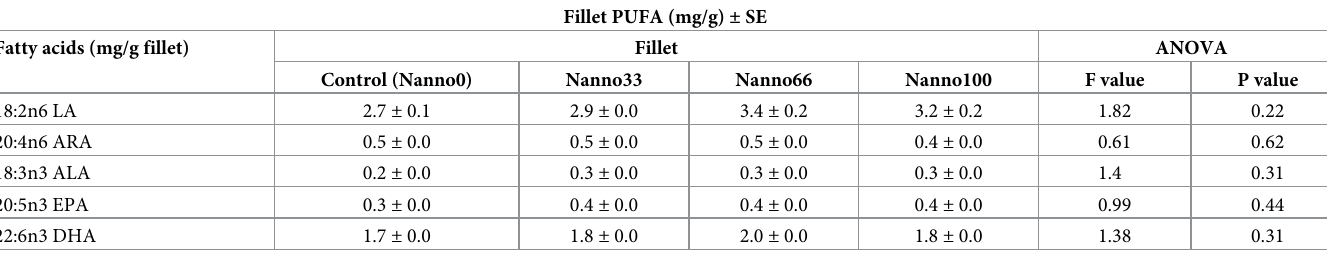
Table 14. Amounts of lipid and major n3 and n6 PUFA in the fillet (wet weight basis) of Nile tilapia fed experimental diets for 84 days; average ± SE for 3 replicates per diet (pooled whole tissues of 5 fish/replicate). Fillet PUFA (mg/g) ±